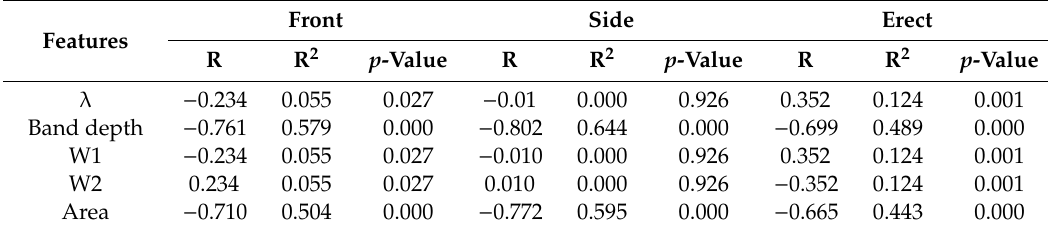
Table 6. Correlation between continuum removal features and disease severity.